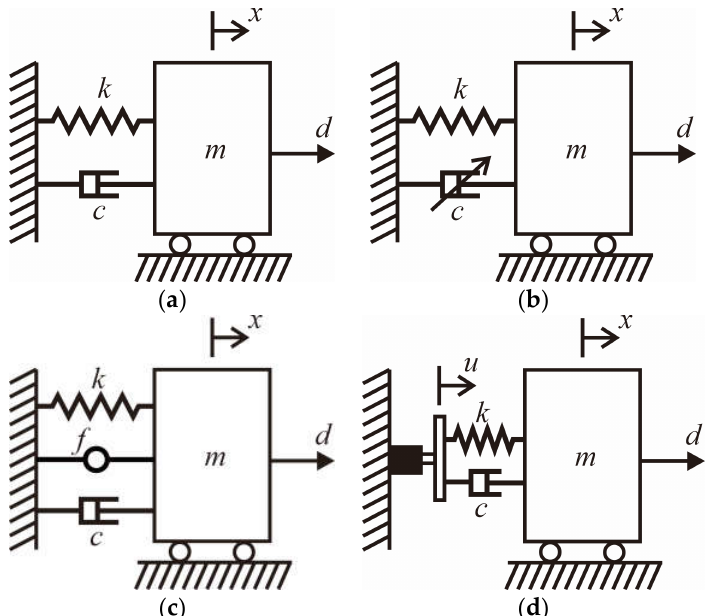
Figure 1. Vibration control systems. ( a ) Passive system; ( b ) Semi-active system; ( c ) Parallel active system; ( d ) Serial active system.